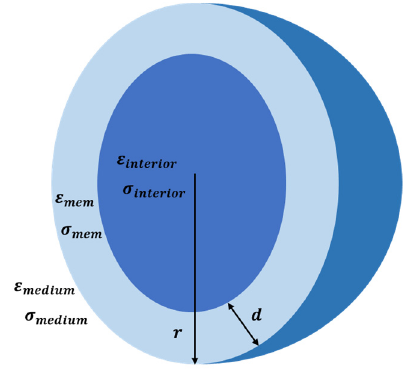
Figure 2. Schematic of a spherical cell with a single shell [59,62]. It can be indicated from Equation (3) that the magnitude of the DEP force is propor- tional to the cell size ( r 3 ) and the gradient of the non-uniform electric field ( ∇| E | 2 ),